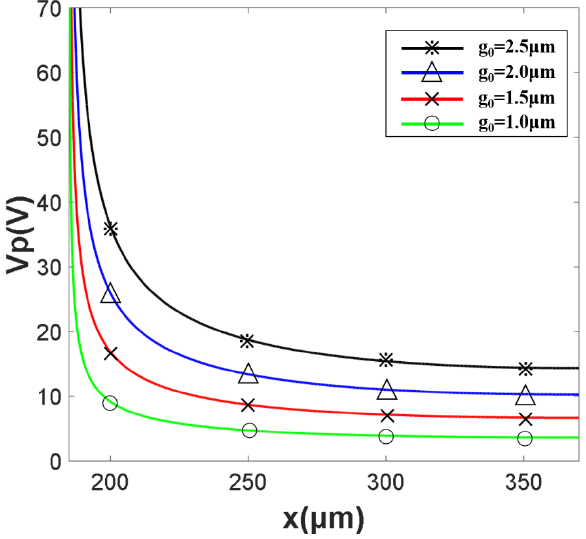
Figure 9. The relationship between the 𝑥 , 𝑔 0 and 𝑉 𝑝 . 2.3. Design of the High Capacitance Ratio RF MEMS Switch and Simulation